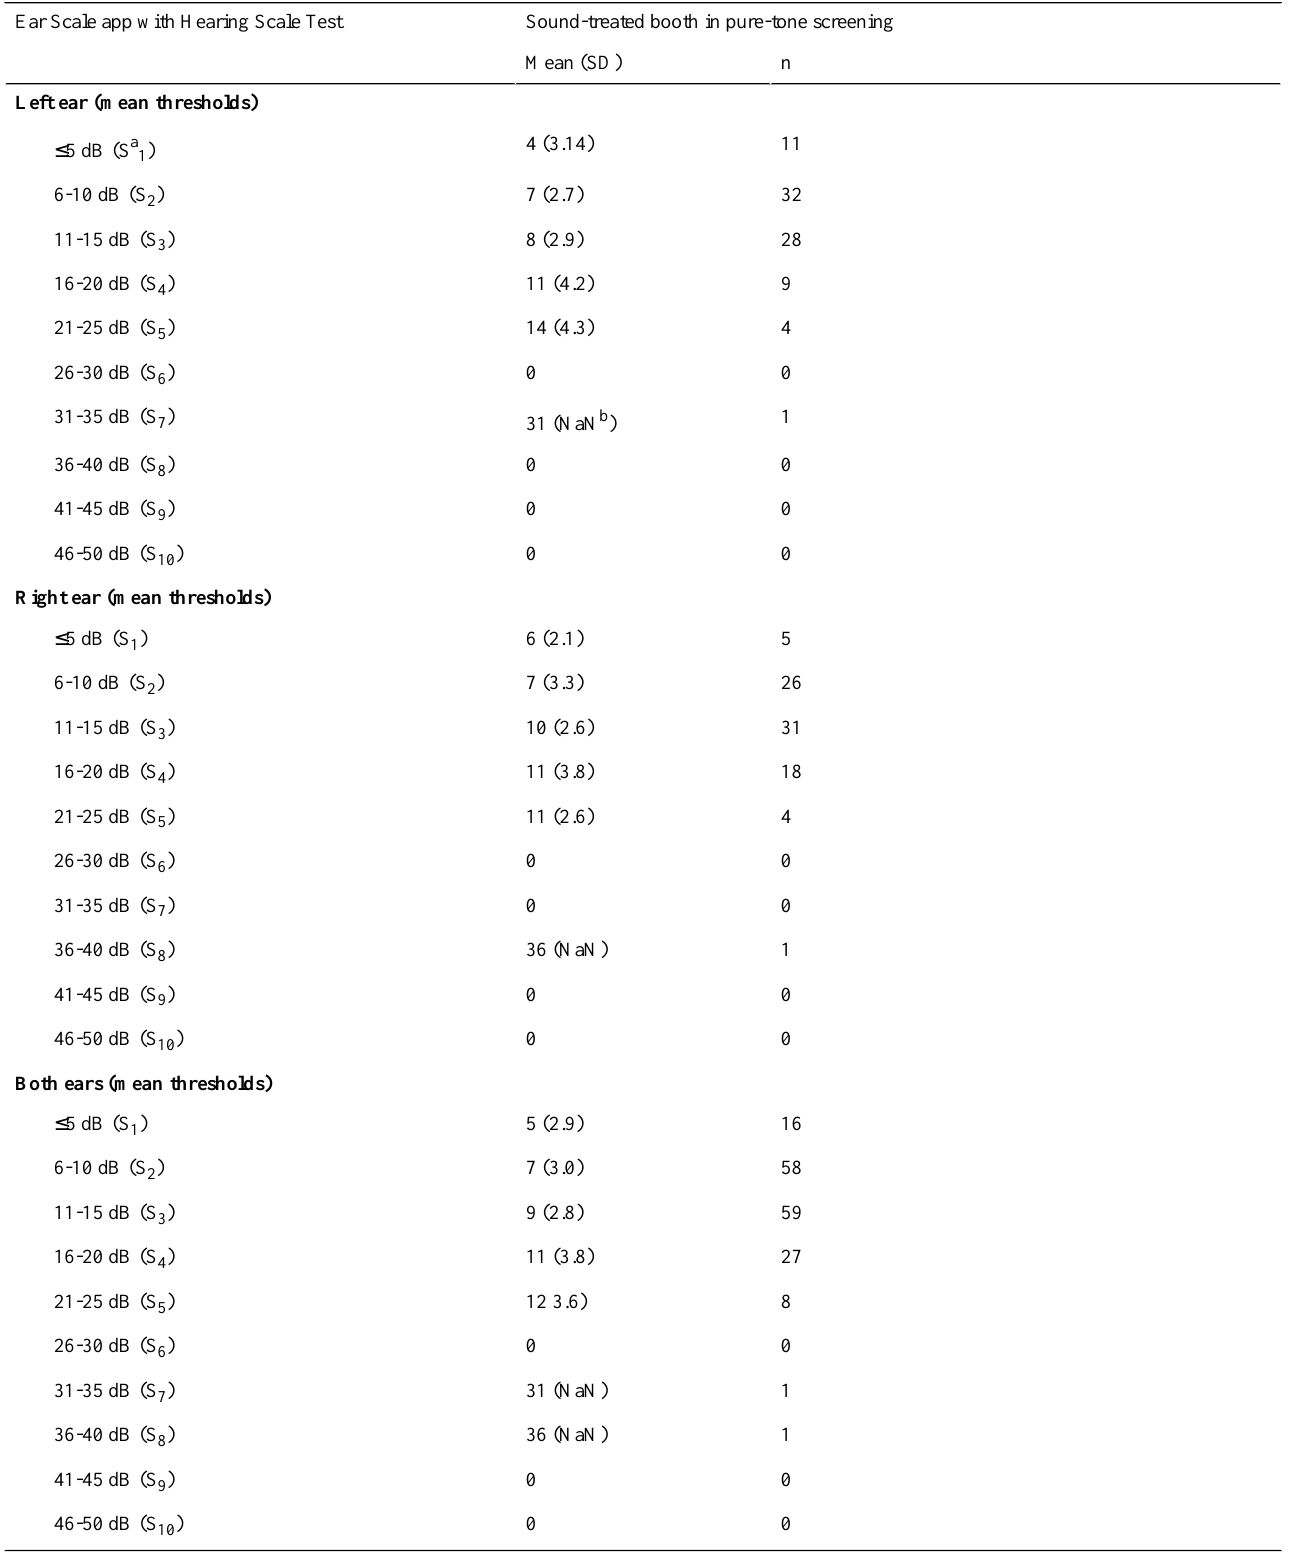
Table 3. The Hearing Scale Test and the mean difference between thresholds (dB) for the Ear Scale app and sound-treated booth (N=170 ears).